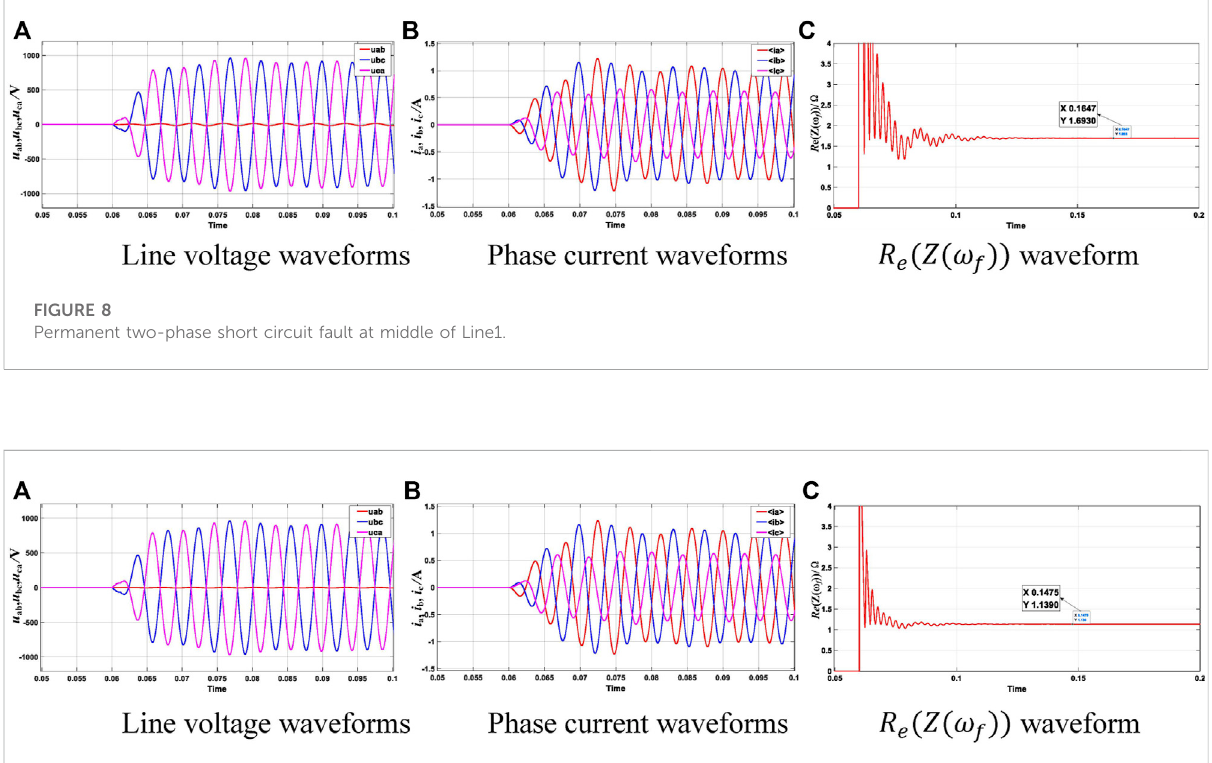
FIGURE 9 Permanent two-phase short circuit fault at head of